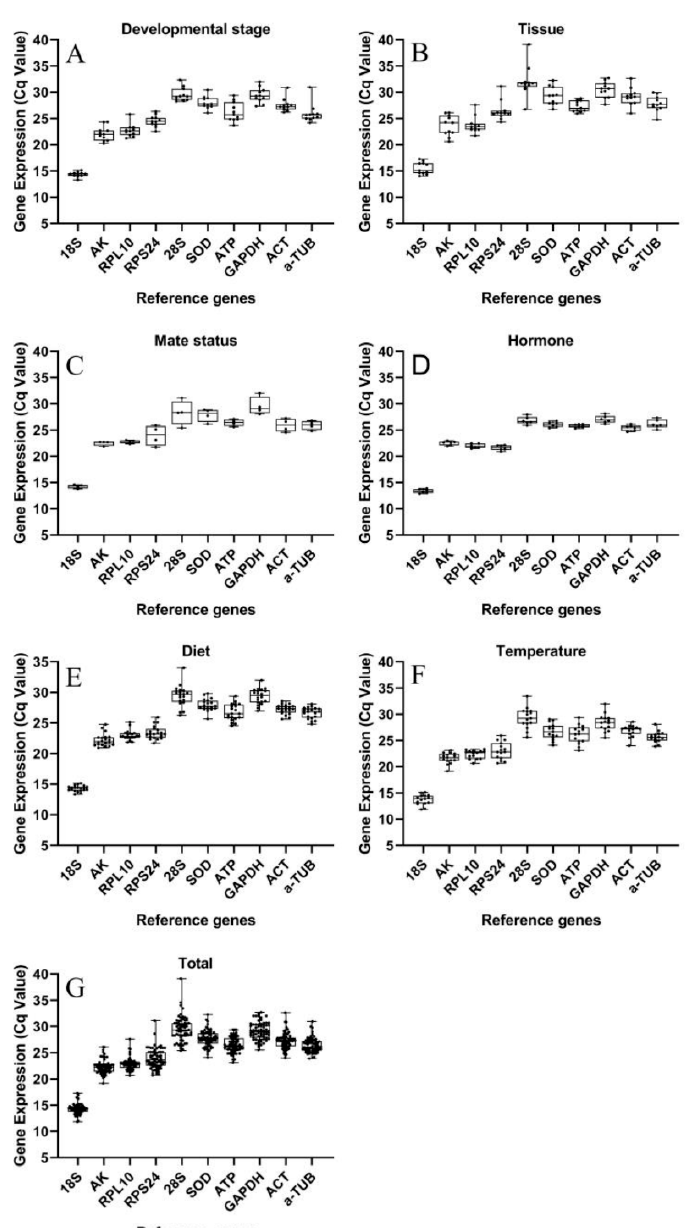
Figure 1. Expression profiles of 10 candidate reference genes of S. frugiperda in different treatments. ( A ) different developmental stages (n = 33); ( B ) various tissues (n = 33); ( C ) mating status (n = 12); ( D ) hormone treatment (n = 18); ( E ) diets treatment (n = 60); ( F ) temperature treatment (n = 45); ( G ) all samples (n = 201); the Ct values indicate the expression levels of reference genes and n represents the number of samples used to derive values; the box represents the 25th to 75th percentiles and the line in the box represents the median, and the bars represents the minimum and maximum.